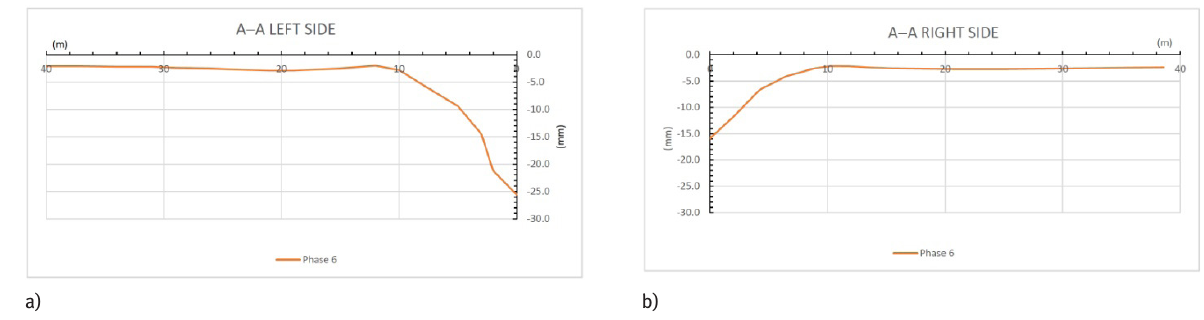
Figure 9: Phase 6 of the implementation – implementation of the raft foundation; graph of vertical displacements of the land surface in the A–A cross section: a) on the left, b) on the right.